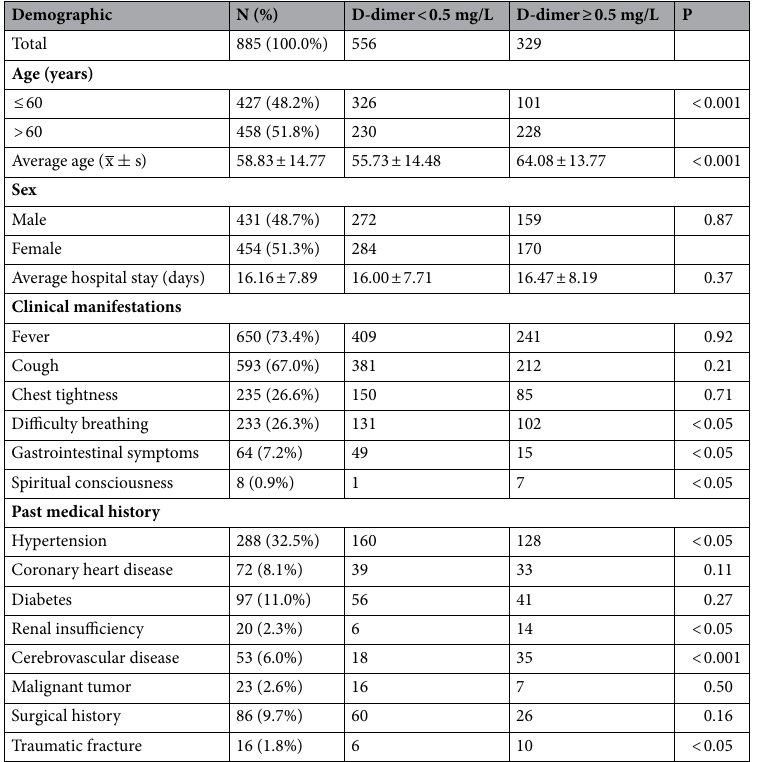
Table 1. General demographic characteristics and clinical manifestations of 885 COVID-19 patients with D-dimer (first lab test). Normal range of D-dimer value: < < 0.5 mg/L.